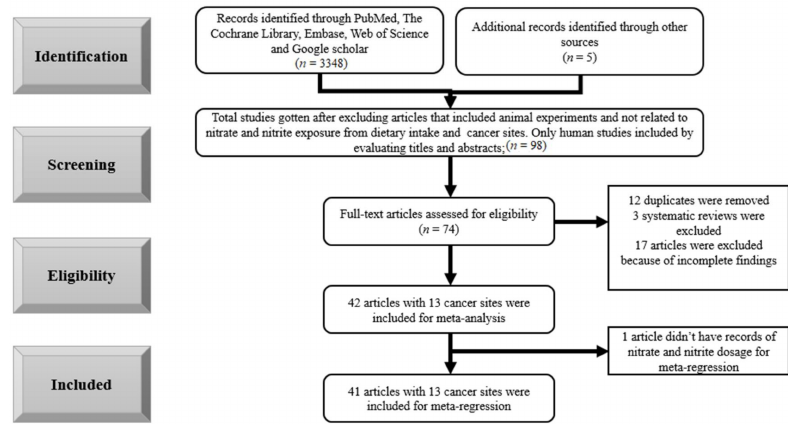
Figure 1. Flow chart of study selection.